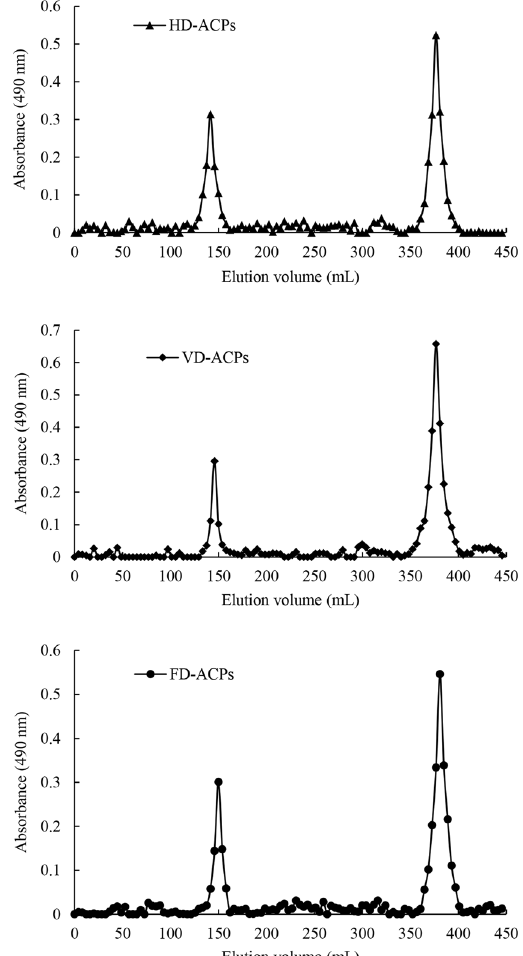
Figure 4. Molecular weight distribution of polysaccharides from Astragalus cicer L. dried by three methods: HD-ACPs dried by hot air drying method; VD-ACPs dried by vacuum drying method; FD-ACPs dried by freeze drying